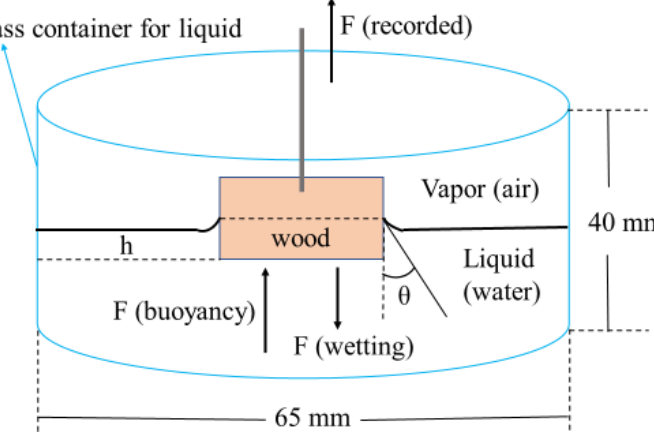
Figure 4. Schematic diagram of the Wilhelmy method.